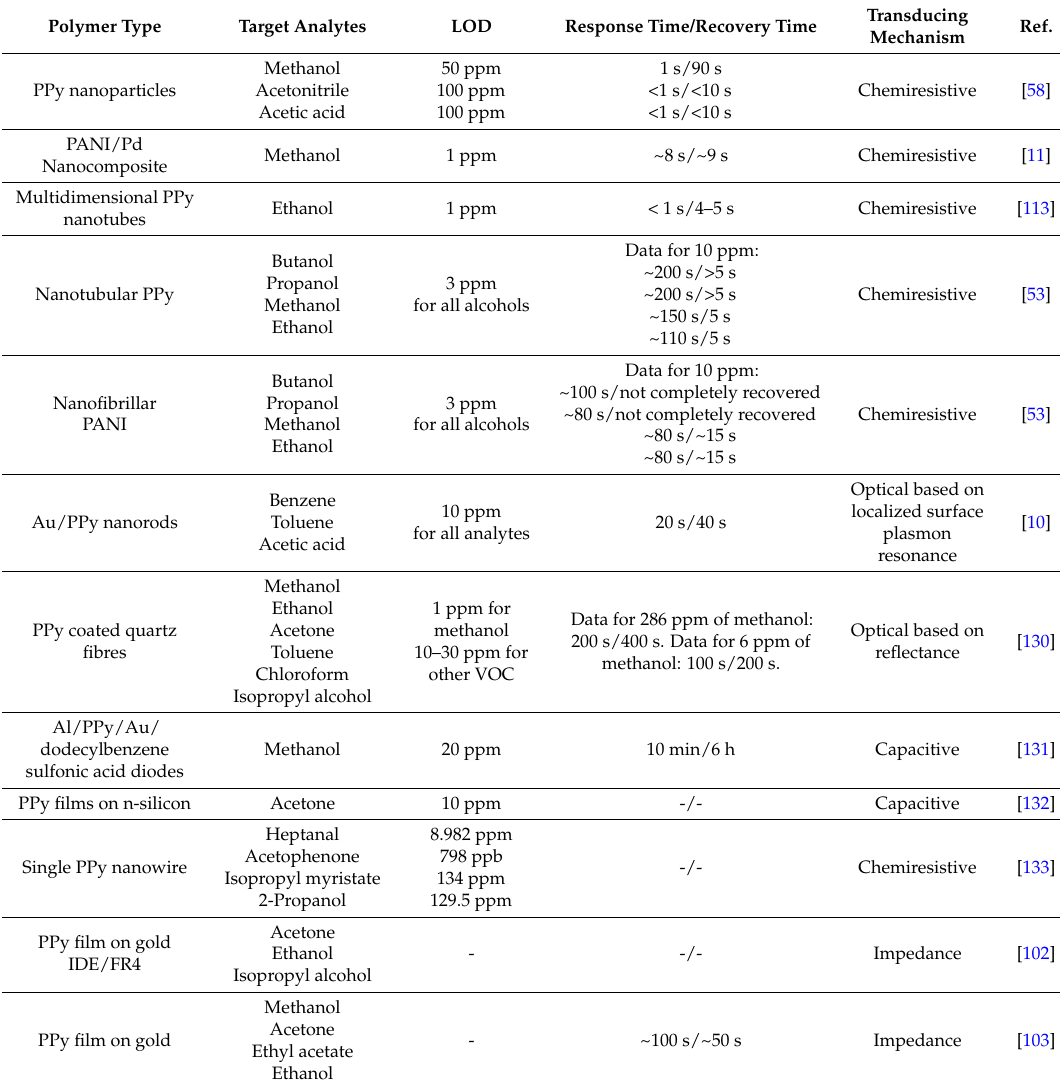
Table 6. Overview of CPs used as active layers for detection of other gases and